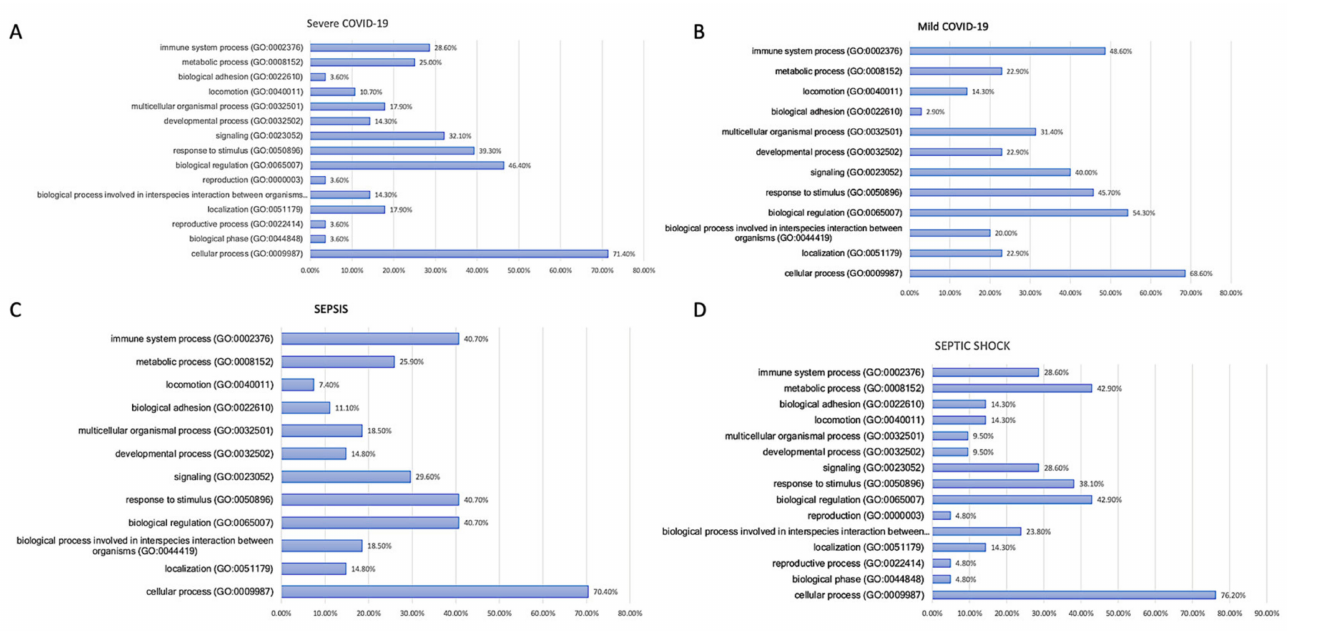
Figure 5. Biological process of the most commonly expressed genes in different cell subtypes across patients. Individually, the unique, most commonly expressed genes in COVID-19 and bacterial sepsis patients with mild and severe disease manifestations, found in Supplementary Material S2, were submitted to the PANTHER software. A biological process involvement analysis of the genes was returned by the software and was later coded into bar charts. The immune system and multicellular organismal processes were found enriched in the mild COVID-19 cohort ( A , B ) and in the non-severe sepsis cohort ( C ), indicating that both viral and bacterial induced sepsis are similar with respect to their biological processes. Septic shock patients demonstrated a higher upregulation of the metabolic pathway when compared to both severe COVID-19 patients and those with a mild form of the disease ( D